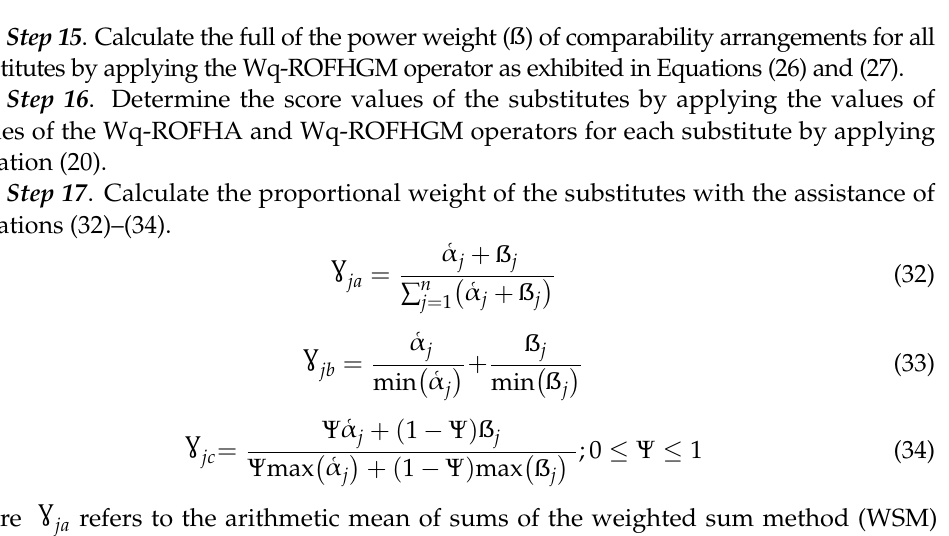
Table 4. Combined evaluation matrix for alternatives in terms of the criteria based on q-ROFN.